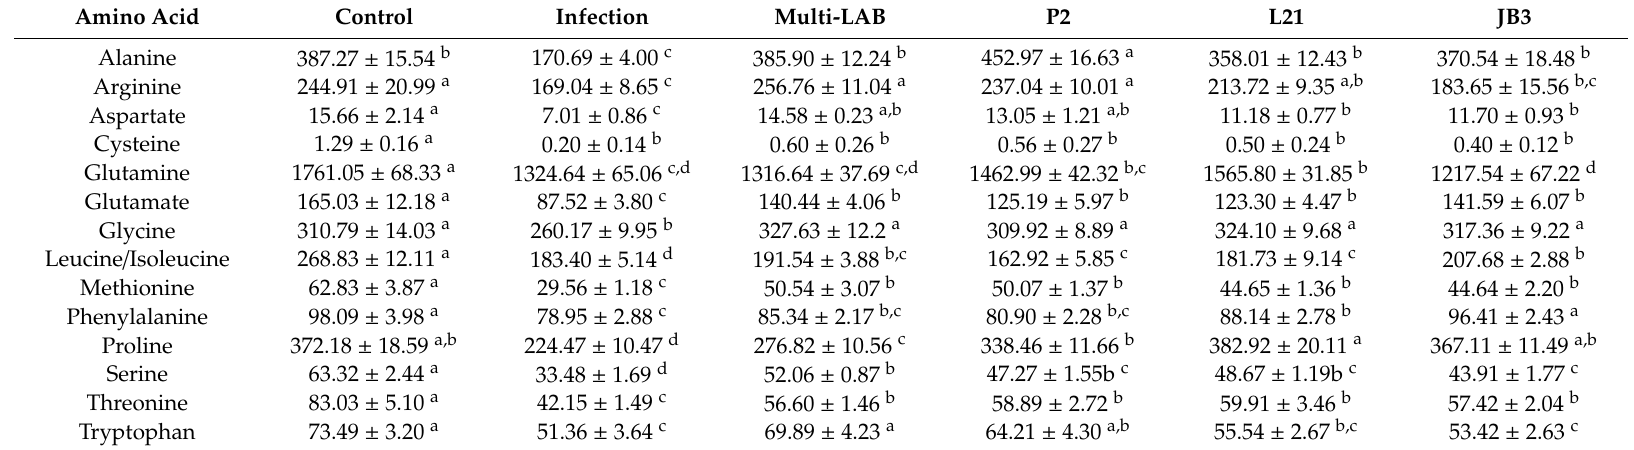
Table 1. E ff ects of LABs on amino acid concentrations ( µ M) in serum of H. pylori -infected mice. Values are mean ± SEM, n = 10. a–d Values in a row without a common letter di ff er, p < 0.05.